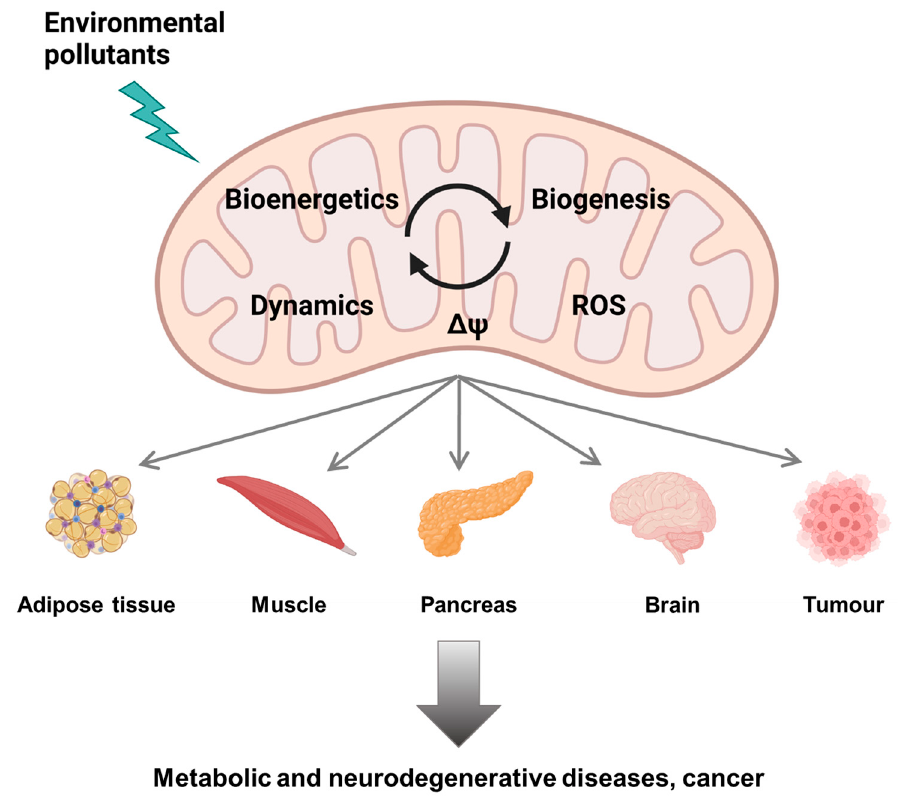
Figure 1. Mitochondrial dysfunction by environmental pollutants (created with BioRender.com, accessed on 30 November 2021).